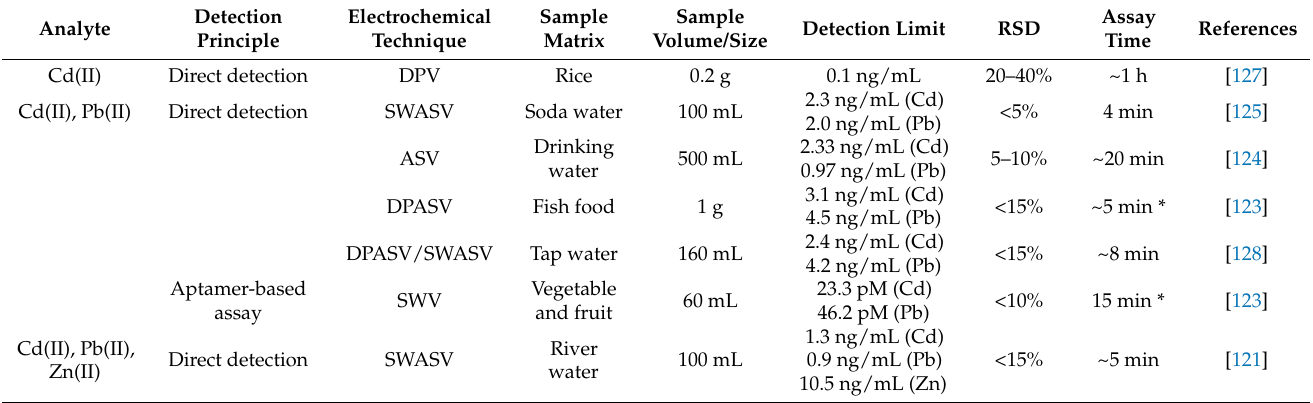
Table 5. Detection of heavy metals in